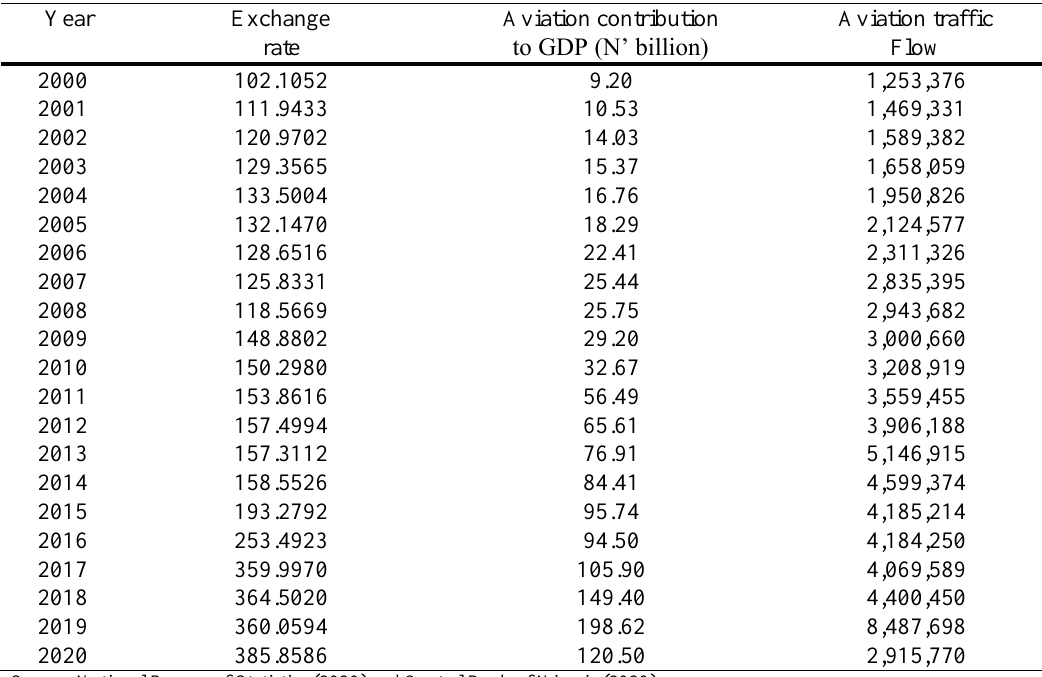
Table 1. Data summary of